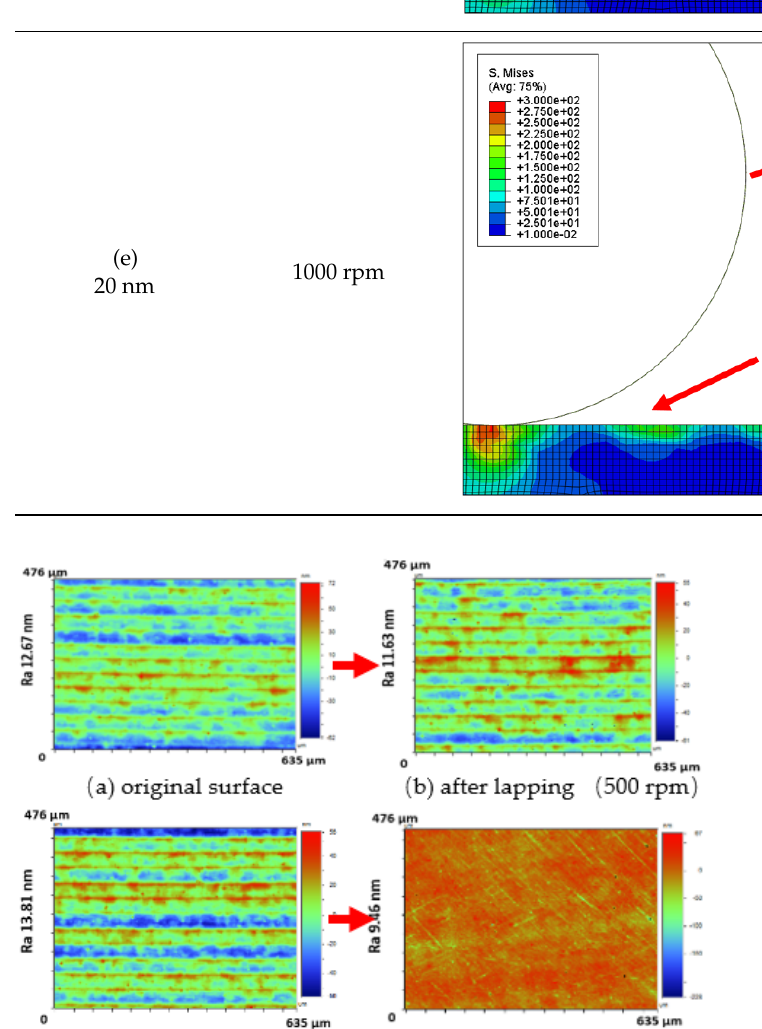
Figure 7. Stress–time curve of 1000 nm tool mark surface under different speeds. Figure 8. Stress–time curve of 20 nm tool mark under different speeds.